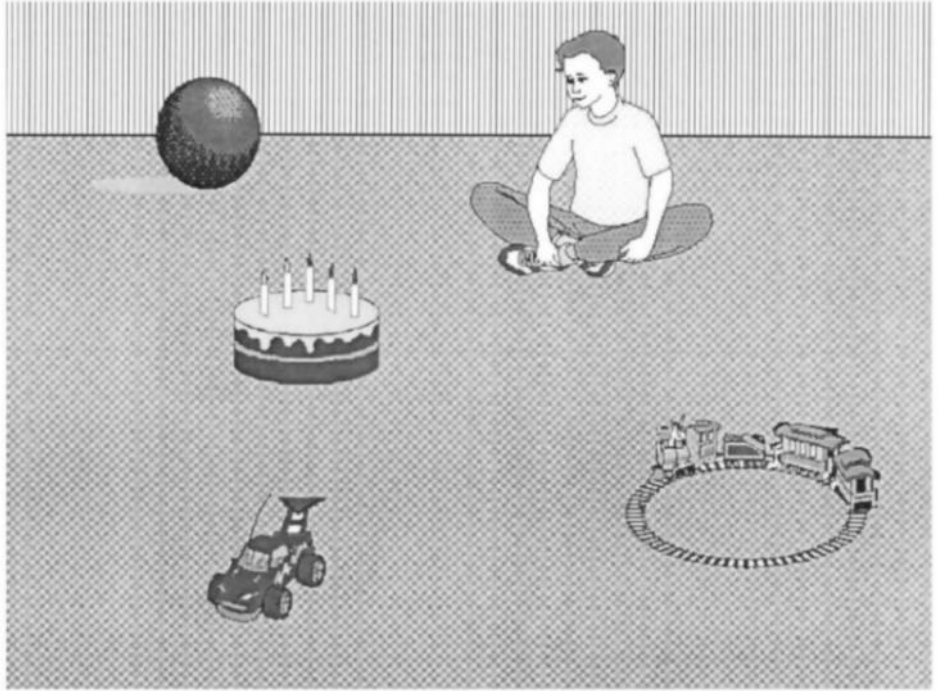
Figure 2. Example of a semi-realistic scene for the sentence The boy will eat the cake. Reprinted with permission from [25]. Copyright 1999 Elsevier.